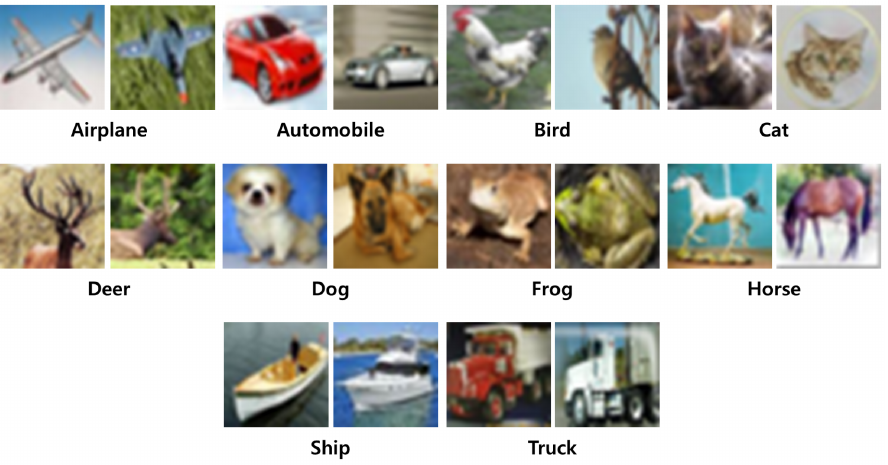
Figure 9. The example images in the CIFAR-10 dataset and their classes for image classification tasks.